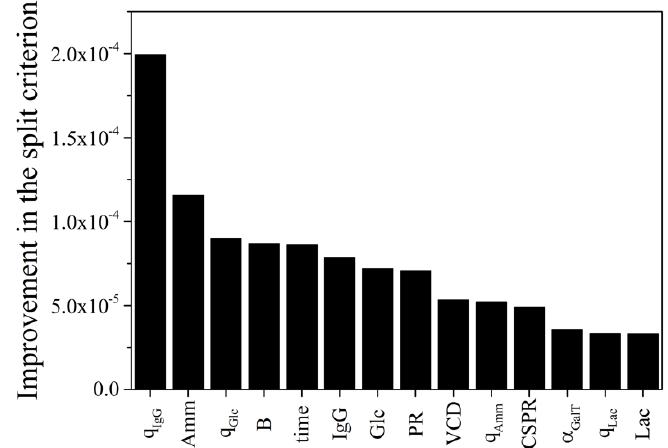
Figure 8. Ranking of predictors based on importance. The predictors are sorted in decreasing impurity gains as measured by the improvement in the split criterion.